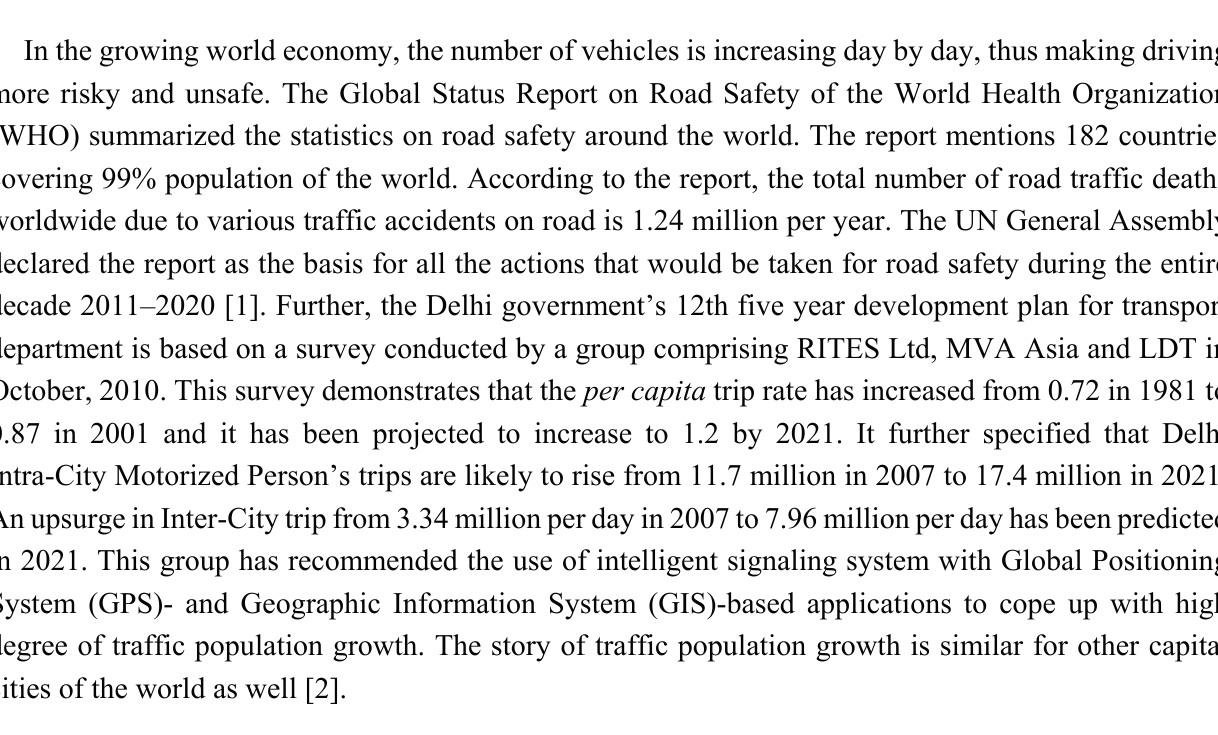
Figure 1. Vehicle-to-Vehicle (V2V) and Vehicle-to-Infrastructure (V2I)